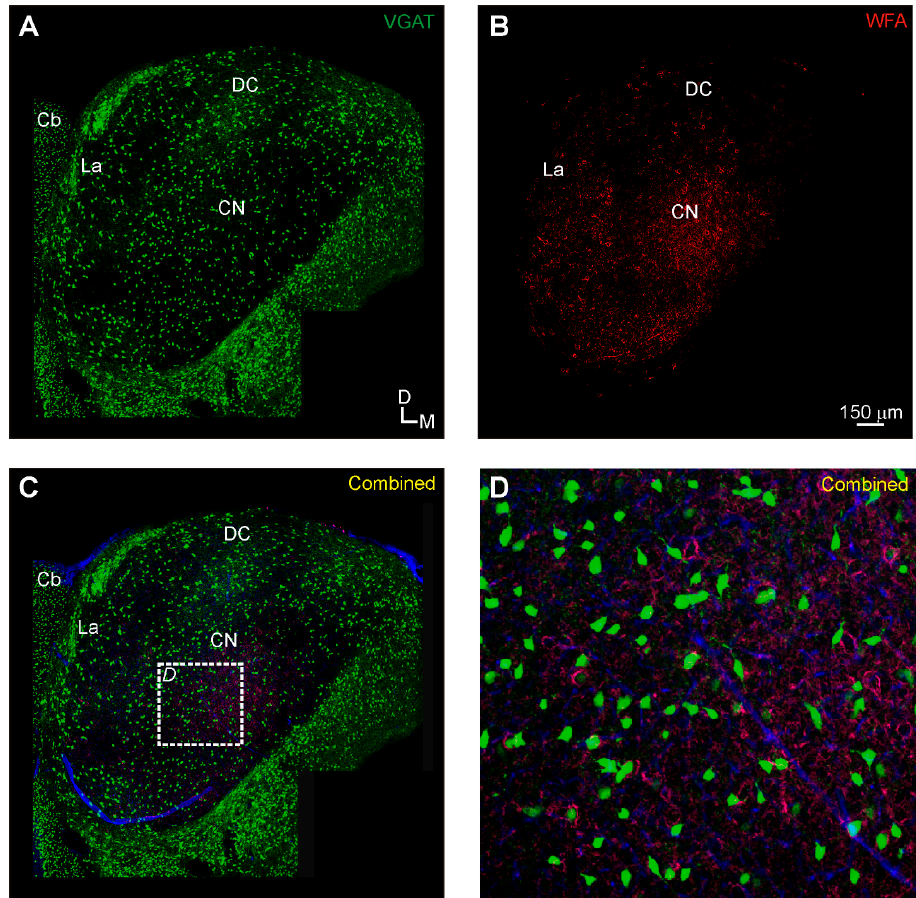
Figure 1. Inferior colliculus (IC) expression of Venus-positive neurons and WFA-labeling in the vesicular gamma-amino butyric acid transporter (VGAT)-Venus C57BL/6 mouse strain: ( A ) Venus-positive neurons (green) are found throughout the IC, with modular clusters in the lateral nucleus (La); ( B ) perineuronal net (PNN) expression (red) is particularly dense in the central nucleus of the inferior colliculus; and ( C – D ) VGAT-Venus positive neurons are often found surrounded by perineuronal nets. Panel D is a higher magnification image of the boxed region in C. Cb, cerebellum; CN, central nucleus of the IC; DC, dorsal cortex of the IC; La, lateral nucleus of the IC.